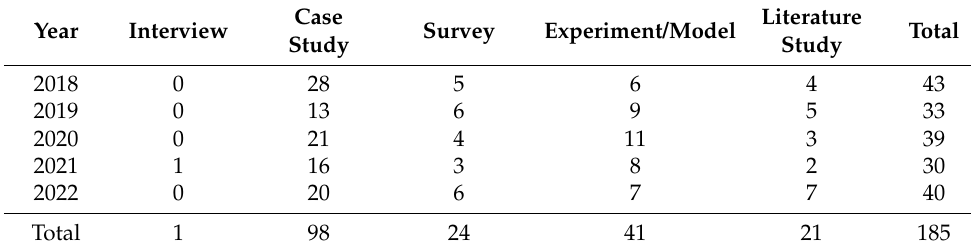
Table 5. Research methodology 2.